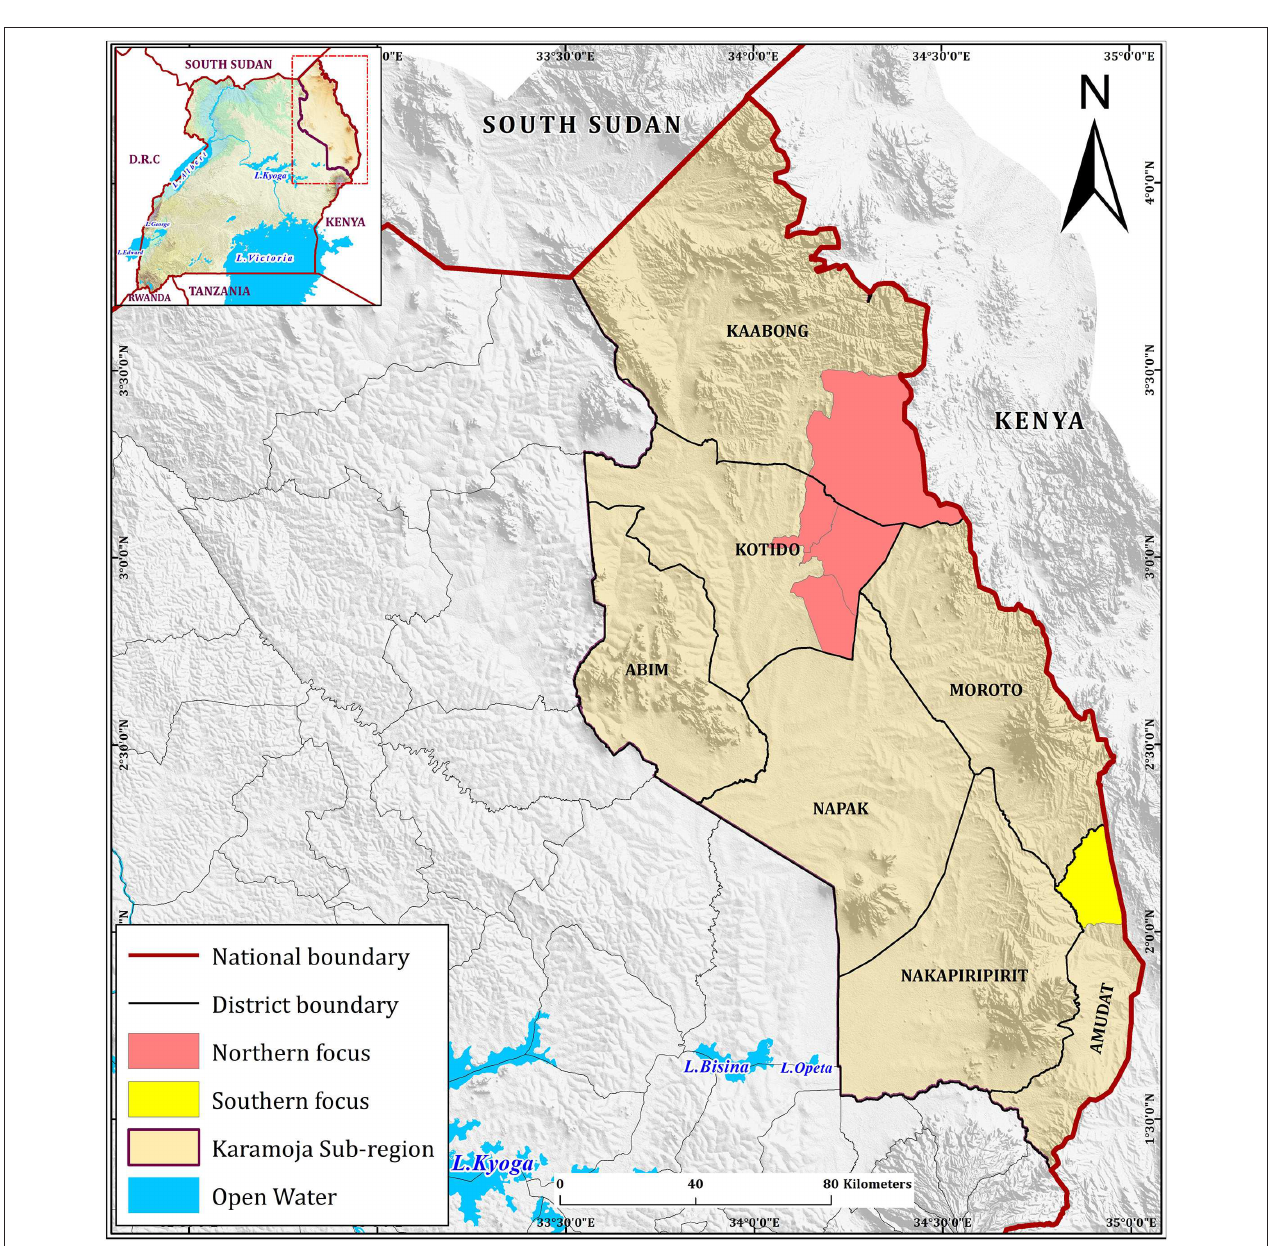
FIGURE 3 | Target sites. The foci identified by the epidemiological assessment are highlighted in red and yellow. The three outbreaks identified by the regional surveillance activity fell within the two foci: two in the northern foci and one in the southern